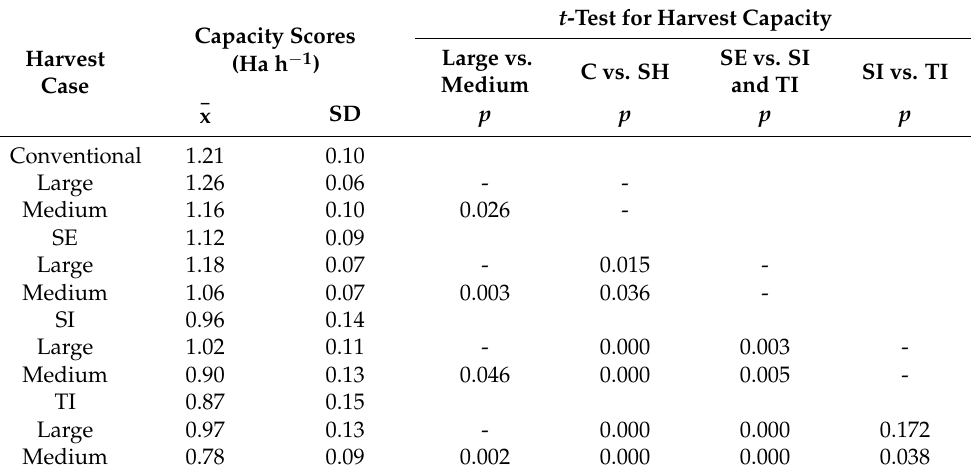
Table 5. Harvest capacities for the four harvesting cases studied and the field size groups, as well as t -test ( p > 0.05) applied to the harvest capacities.